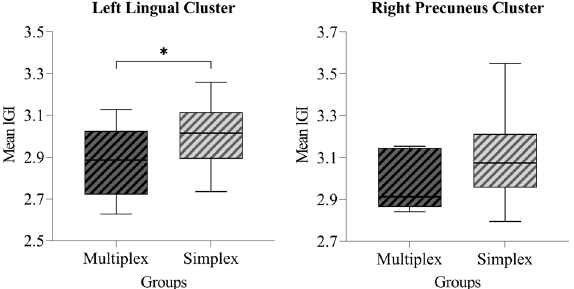
Fig. 2 Relationships between genetic loading and mean local gyri fi cation index (lGI) values within the clusters showing signi fi cantly reduced gyri fi cation in the unaffected relatives (URs). The comparison between the two subgroups of URs in terms of the extracted mean lGI values from the clusters showing signi fi cant differences between the URs and healthy controls (HCs). The error bars indicate 95% con fi dence intervals. * p <